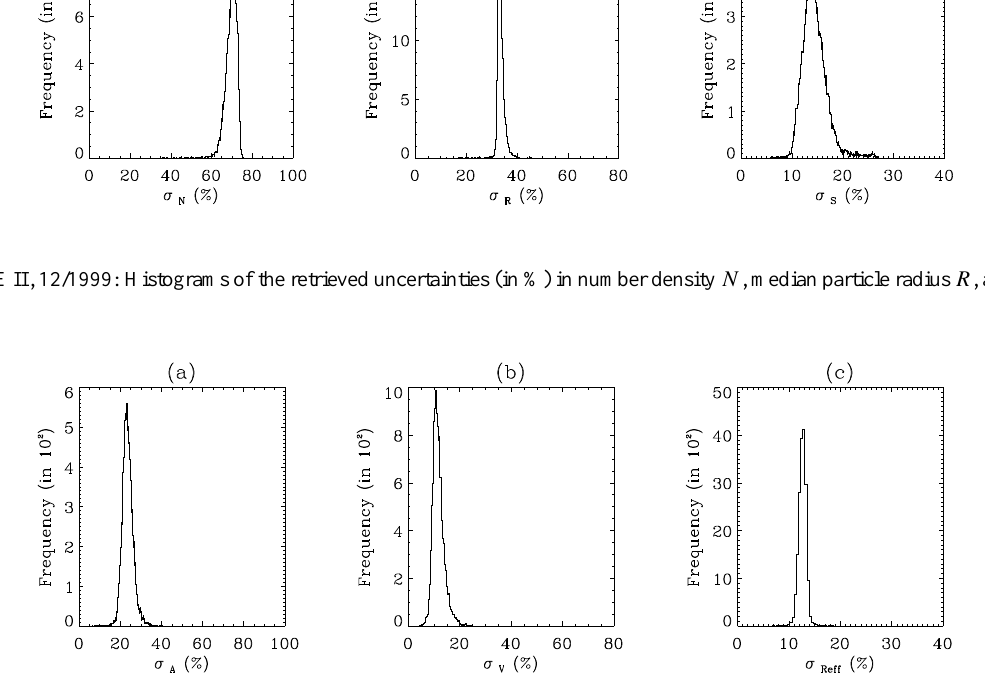
Fig. 11. SAGE II, 12/1999: Histograms of the uncertainties (in %) associated with surface area density (a) , volume density (b) , and effective radius (c) .